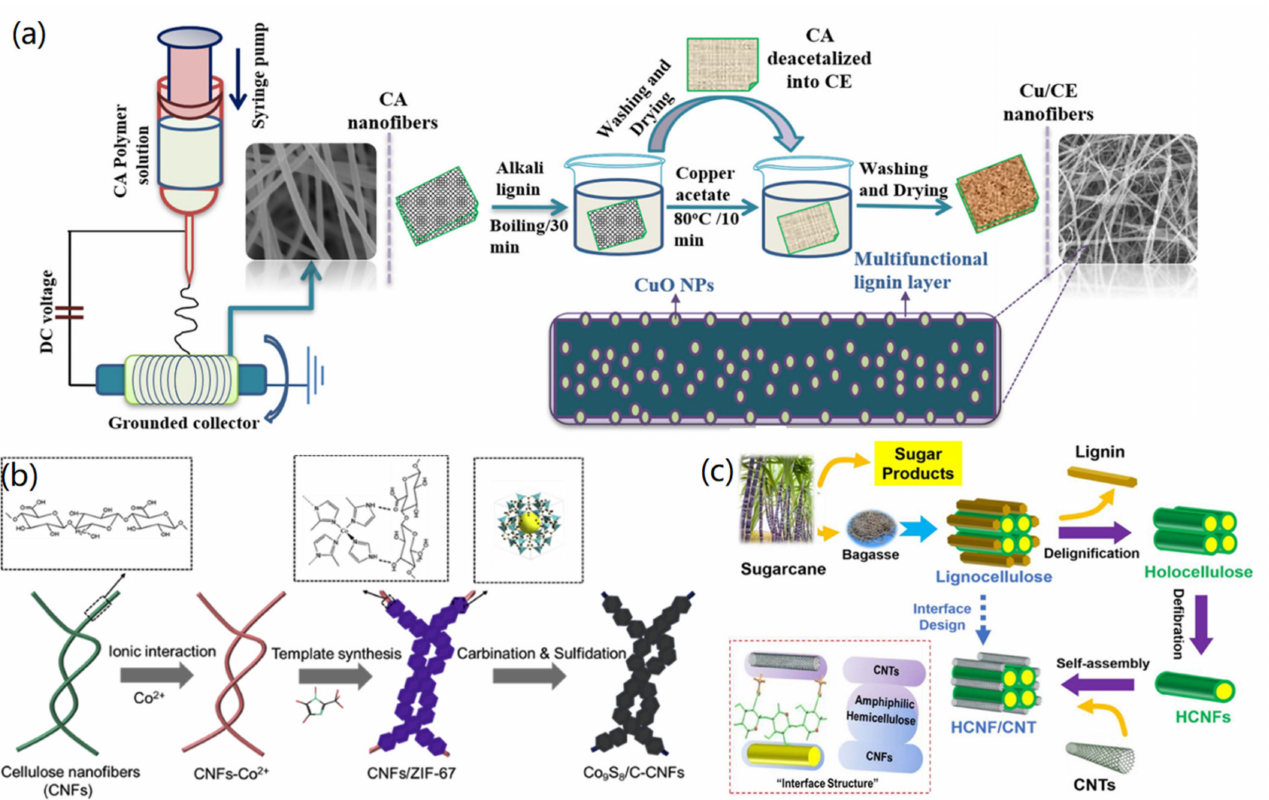
Figure 1. Synthesis of CNF-based 1D hybrid materials: ( a ) CNF/CuO hybrids. Reprinted with permission from Ref. [25], Copyright 2021, Elsevier Ltd. ( b ) CNF/MOF hybrids. Reprinted with permission from Ref. [33], Copyright 2020, Elsevier Ltd. ( c ) HCNF/CNT hybrids. Reproduced with permission from Ref. [34], Copyright 2020, American Chemical